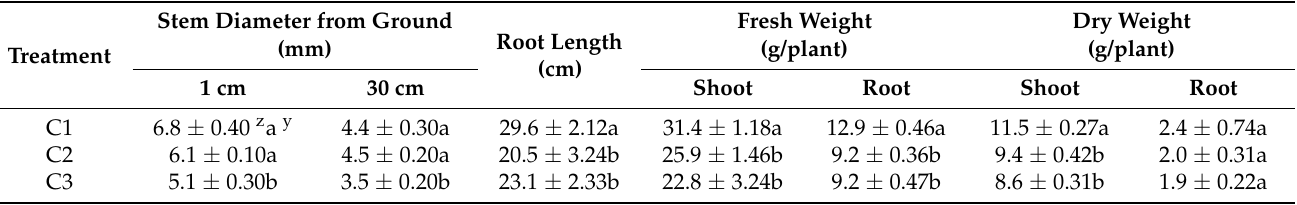
Figure 6. Effect of container size on plant height ( A ), leaf number ( B ), leaf area ( C ) and node number ( D ) of M-9 apple rootstock plant at 11 weeks after treatment in a greenhouse. C1, C2 and C3 indicate container size 1000 mL, 500 mL and 300 mL, respectively. Lines above bar represent the standard error of the mean ( n = 5). Means above each bar followed by the same letters are not significantly different by Duncan’s multiple range test (DMRT) at p ≤ 0.05. Table 3. Effect of container size on stem diameter, root length, fresh weight and dry weight of M-9 apple rootstock plants at 11 weeks after treatment. C1, C2 and C3 indicate container size 1000 mL, 500 mL and 300 mL, respectively. Stem Diameter from Ground (mm) Root Treatment